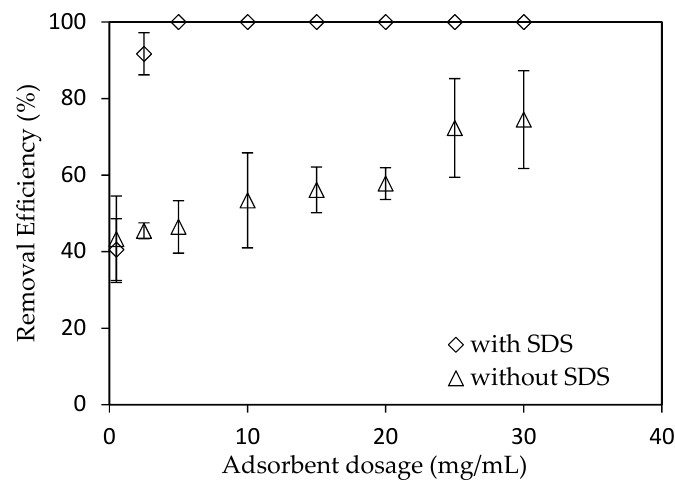
Figure 9. The effect of adsorbent dosage on RhB removal using synthesized nano γ -Al 2 O 3 without SDS modification ( C i (RhB) = 10 − 6 M) and with SDS modification. ( C i (RhB) = 10 − 4 M).